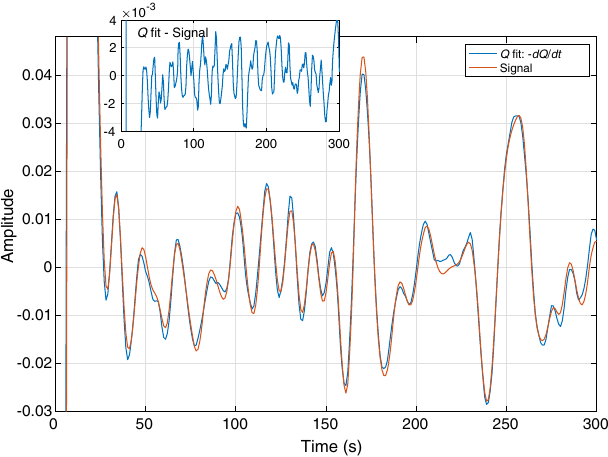
from noise in Sec. VII.